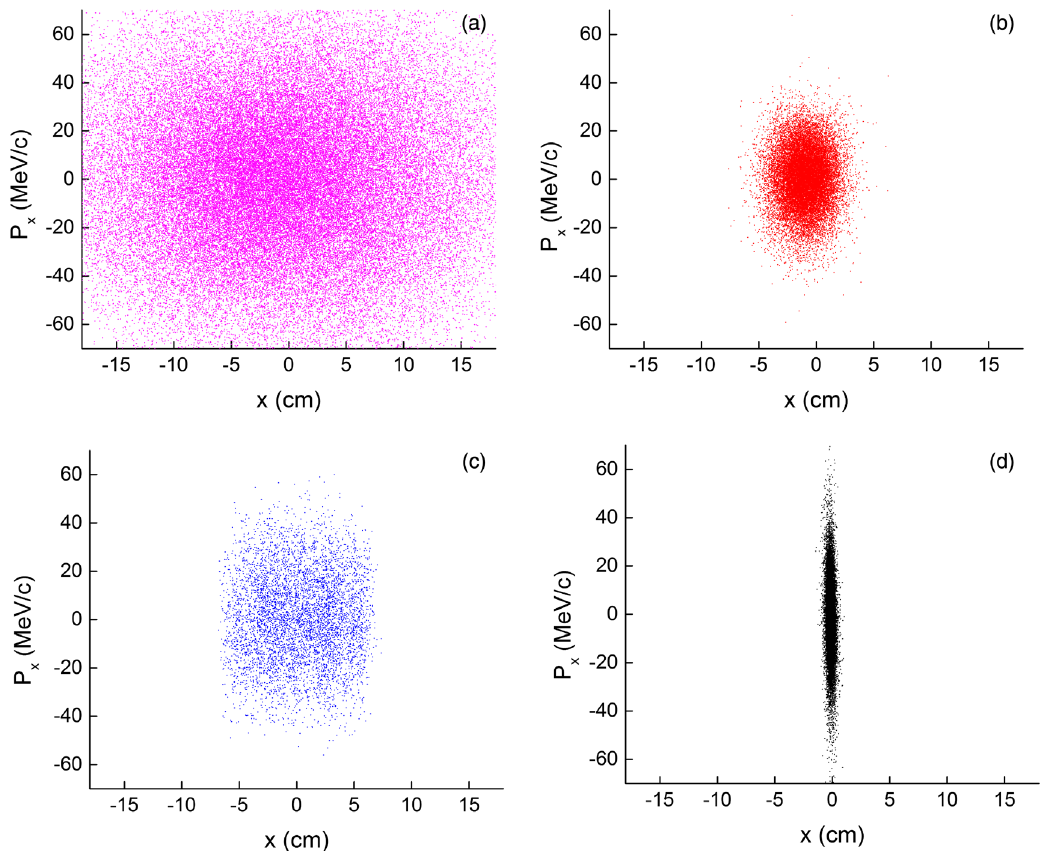
FIG. 9. Snapshots of the transverse phase space at various positions along our proposed 6D rectilinear cooling channel: (a) at the entrance of the cooling channel before recombination; (b) at the entrance of the bunch merger; (c) at the exit of the bunch merger [26]; (d) at the end of the 6D cooling